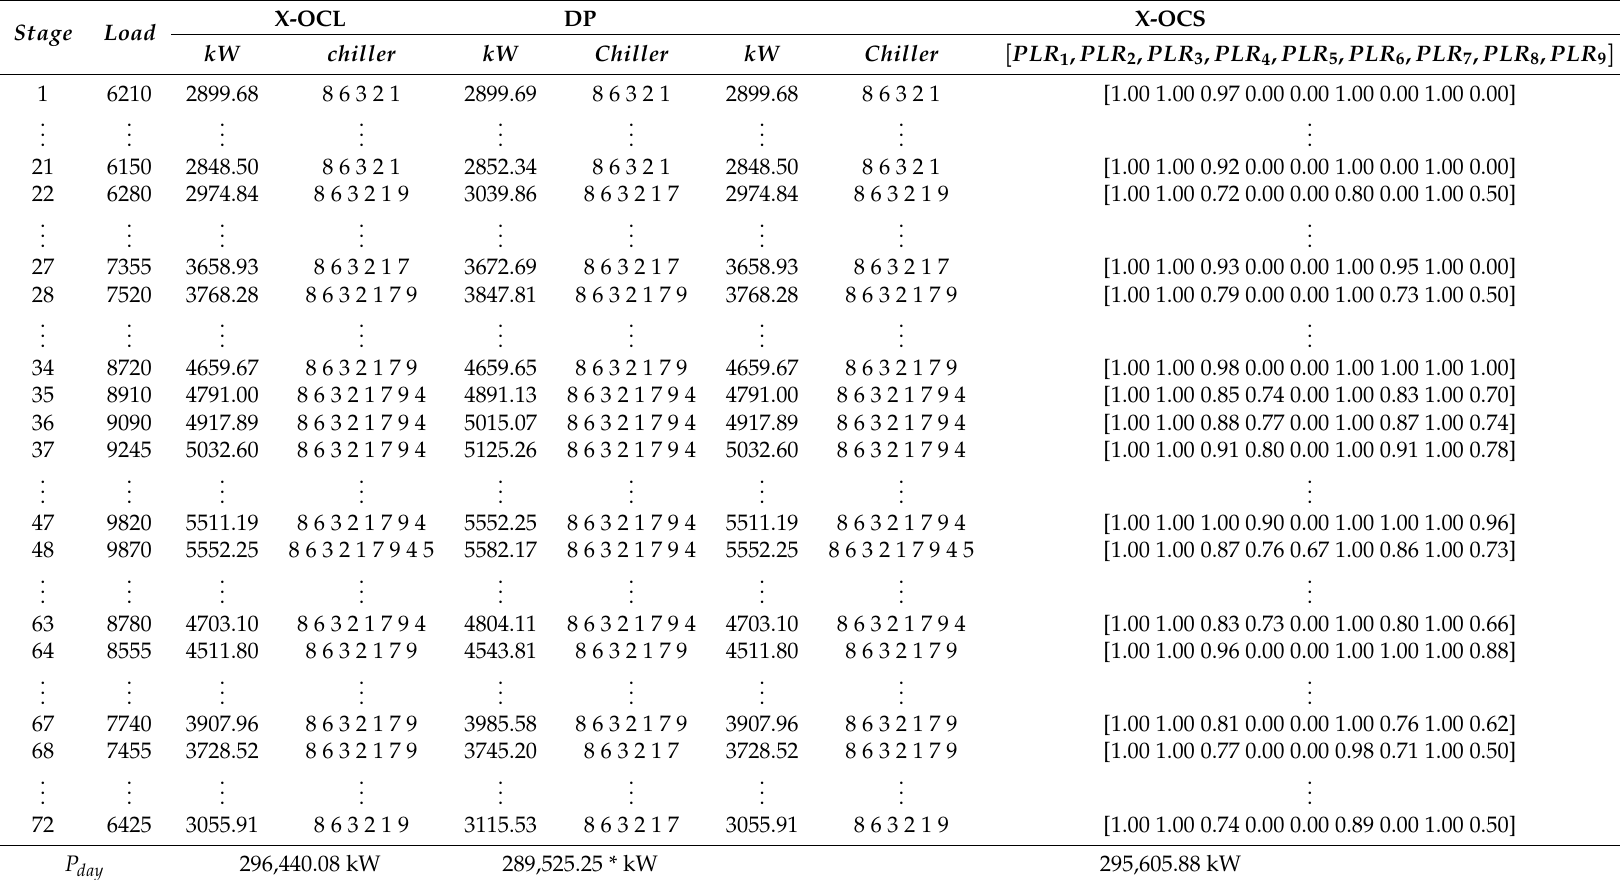
Table 5. Case study